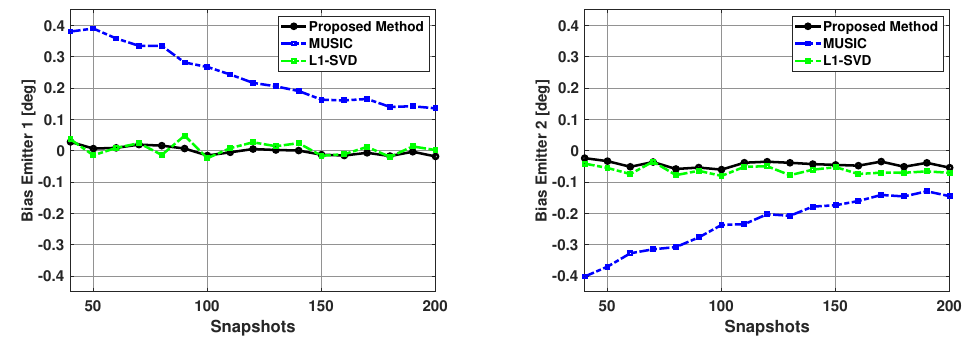
Figure 14. Biases in the estimated direction of the two emitters versus snapshots: Proposed Method, MUSIC Algorithm, and L1-SVD Algorithm, Emitters at 60 and 63 deg, SNR = 5 dB, 500